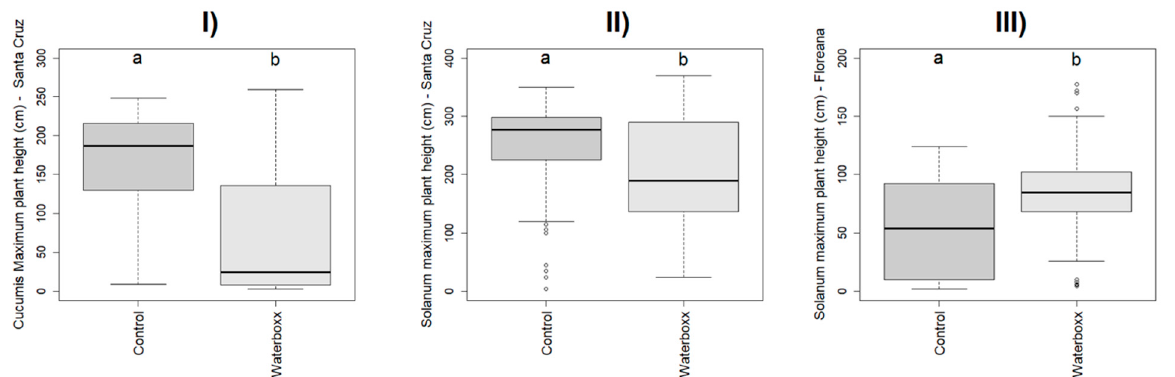
Figure 4. Significant effect of treatments on crop’s maximum plant height in cm. ( I ) Cucumis —Santa Cruz, ( II ) Solanum —Santa Cruz, ( III ) Solanum Floreana. Letters a and b represent significant letters.